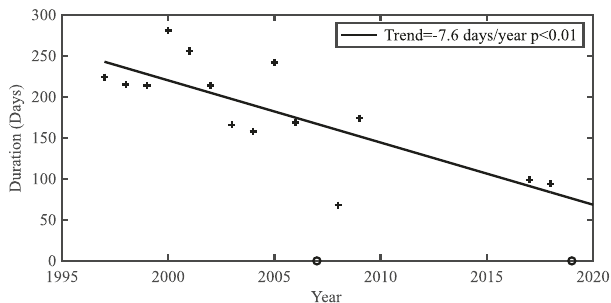
Fig. 9 Time series of duration (days) of ice stoppage along Nares Strait. During 2007 and 2019, indicated by the ‘ o ’ , no arches formed. The linear least squares fi t to the data is also shown along with the trend